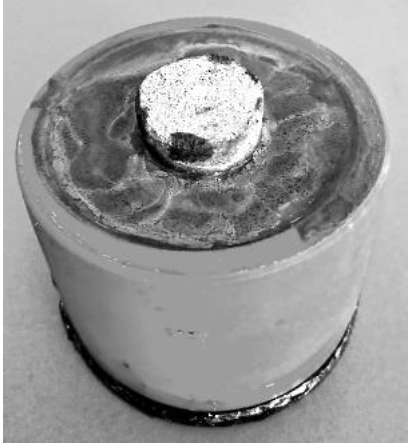
Figure 4. Sample prepared for adhesion tests.